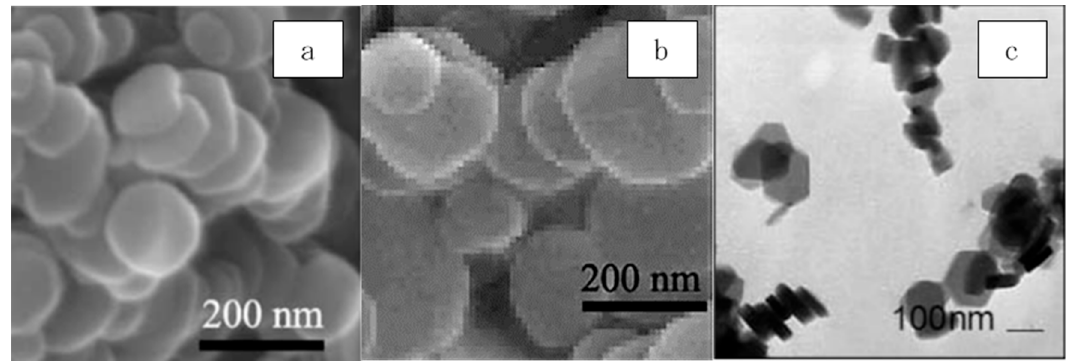
Figure 6. SEM images of LDHs prepared by coprecipitation under hydrothermal condition; aging at 100 °C ( a ) and 150 °C ( b ) for 48 h; and under microwave irradiation; aging at 100 °C ( c ) for 5 h. Reproduced with permission from reference [61,94].